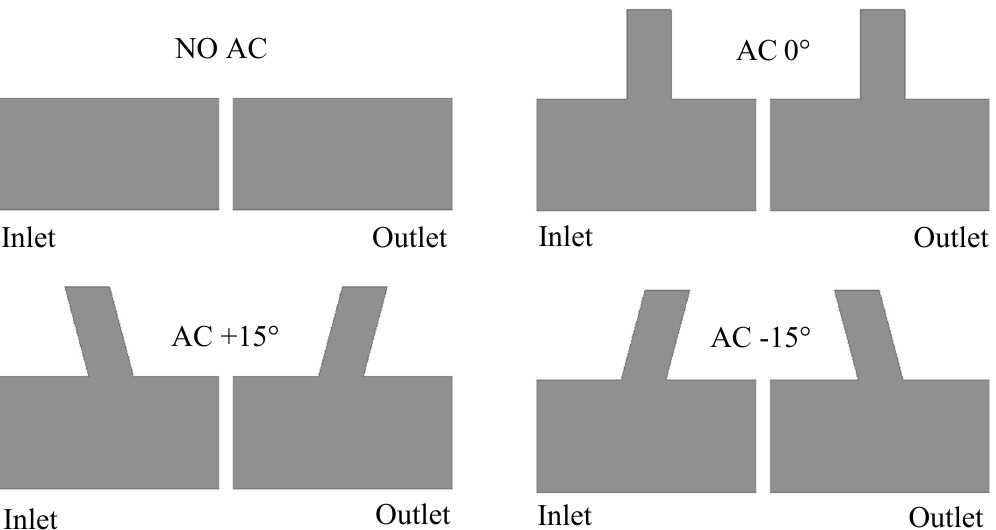
Figure 5. Geometric configurations of the stenter model; ( a ) No air curtain, ( b ) AC tilt angle = 0°, ( c ) AC tilt angle = +15°, ( d ) AC tilt angle = −15°.